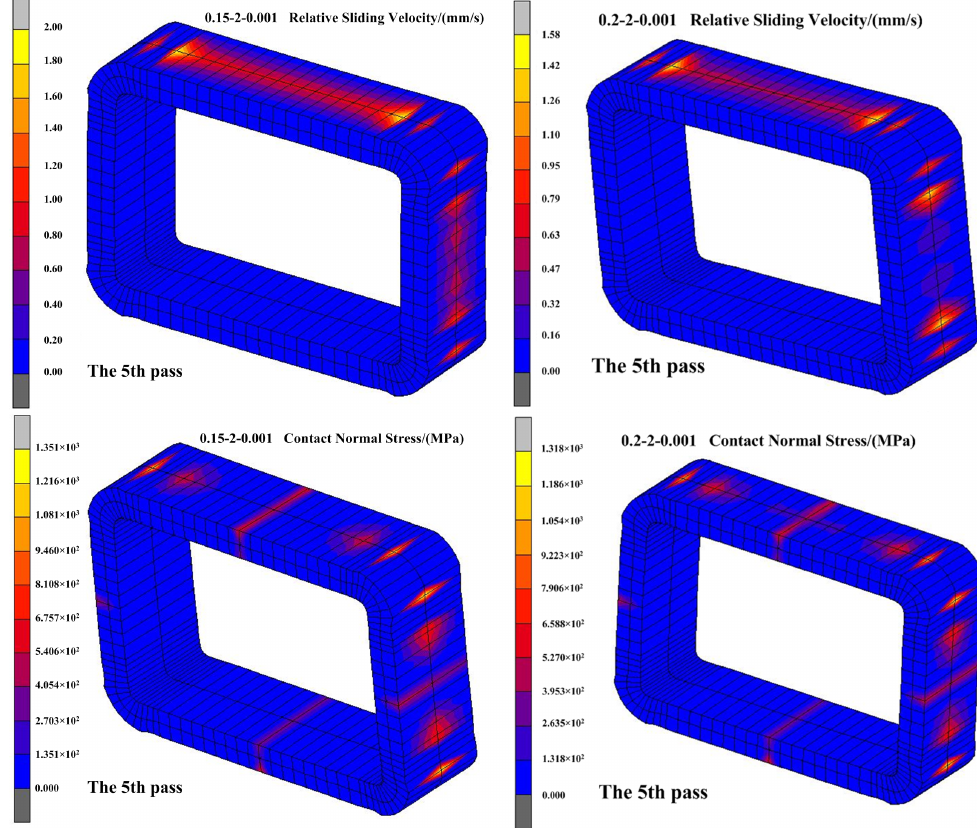
Figure 12. Simulation results of wear parameters under different flat roller friction coefficient.